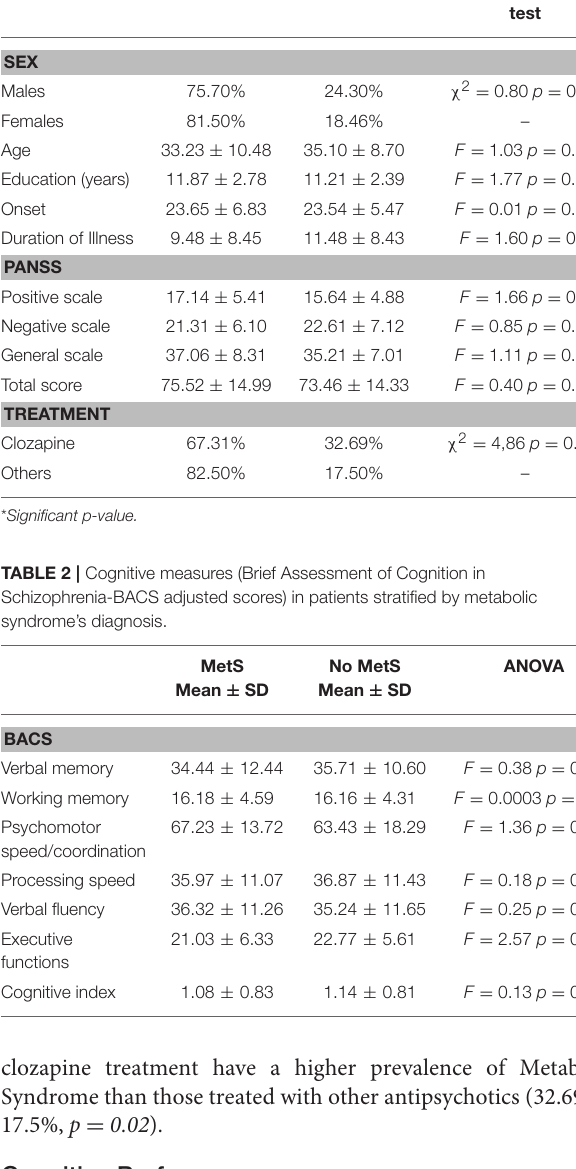
TABLE 3 | Symptoms’ severity (Positive and Negative Syndrome Scale- PANSS TABLE 1 | Clinical and socio-demographical variables of patients, stratified by scores) in patients stratified according to presence or absence of global cognitive Metabolic Syndrome’s diagnosis. No MetS MetS ANOVA/Chi squared test